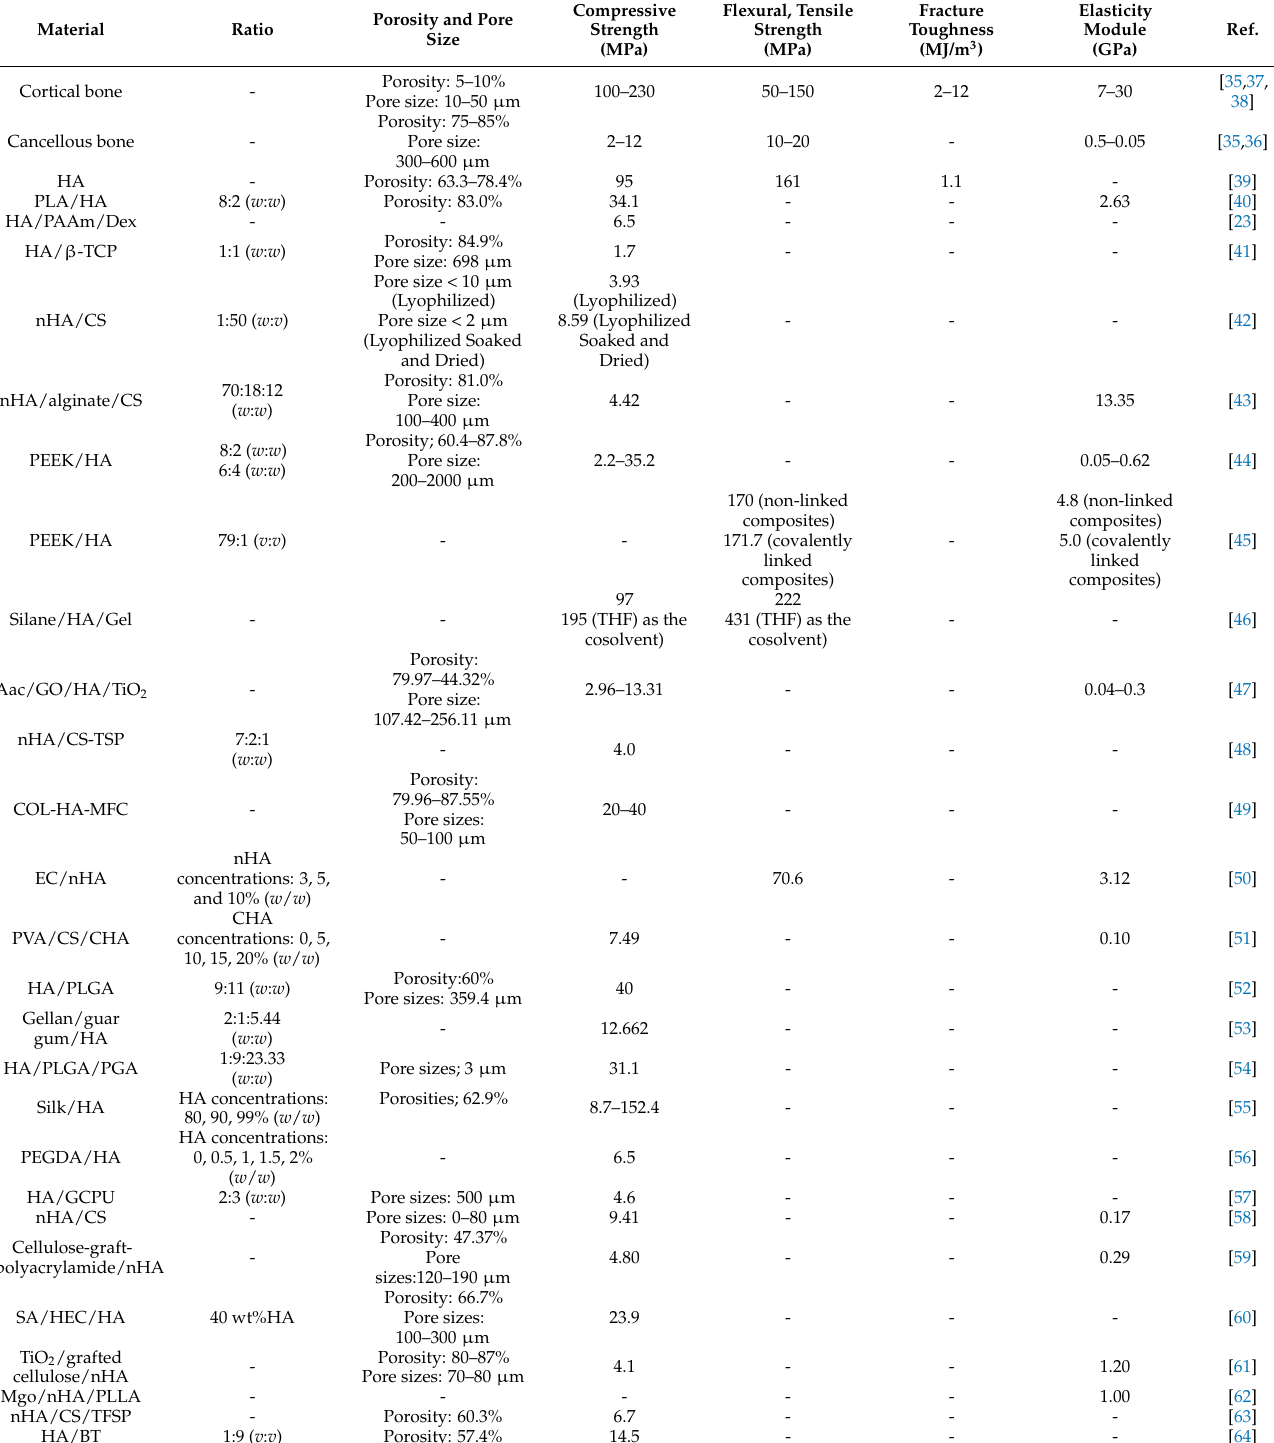
Table 1. Mechanical properties of HA